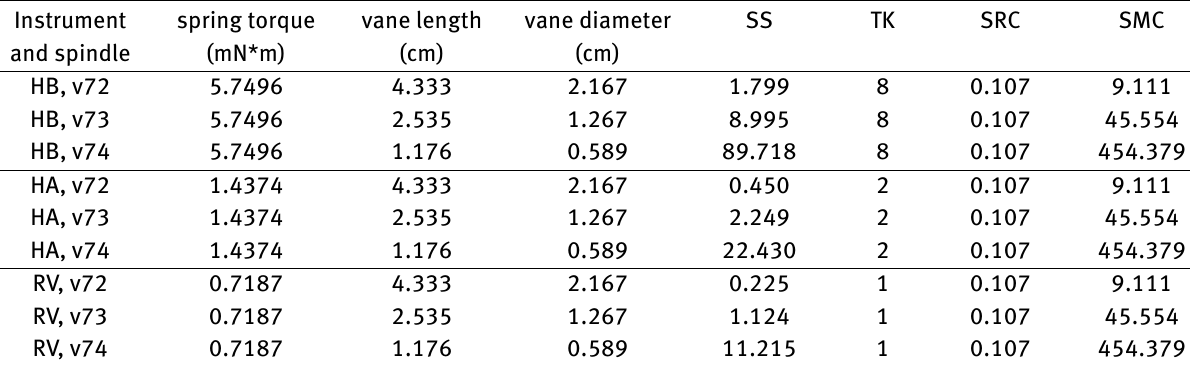
Table 2: Parameters of Brookfield viscometers and vane spindles. Also listed are various conversion constants as explained in the text. Spindle to cup diameter ratio 0.1 is